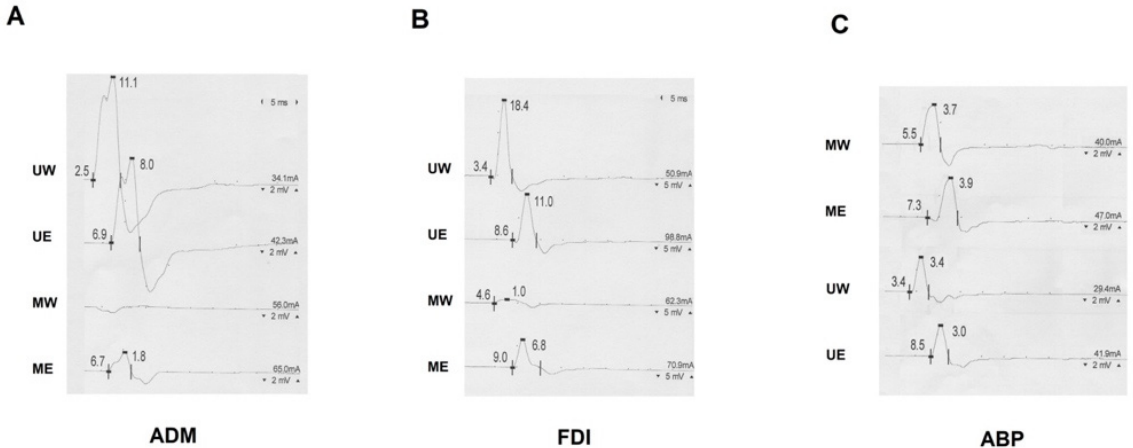
Figure 2. Motor nerve conduction studies from patients with MUC type I ( A ), II ( B ), and III ( C ). ( A ) Recording from ADM, a difference of 3.1 mV was recognizable between U-W and U-BE and an MUC component of 1.8 mV was demonstrated. ( B ) Recording from FDI, a significant drop of 7.4 mV between U-W and U-BE corresponded to a MUC of 6.8 mV, as demonstrated upon ME stimulation. ( C ) A positive onset was evident upon ME but not MW stimulation. MUC—median-to-ulnar communicating branch; ADM—abductor digiti minimi muscle; FDI—first dorsal interosseus muscle; APB—abductor brevis pollicis muscle; U-W—ulnar wrist; U-BE—ulnar below elbow; MW—median wrist; ME—median elbow.